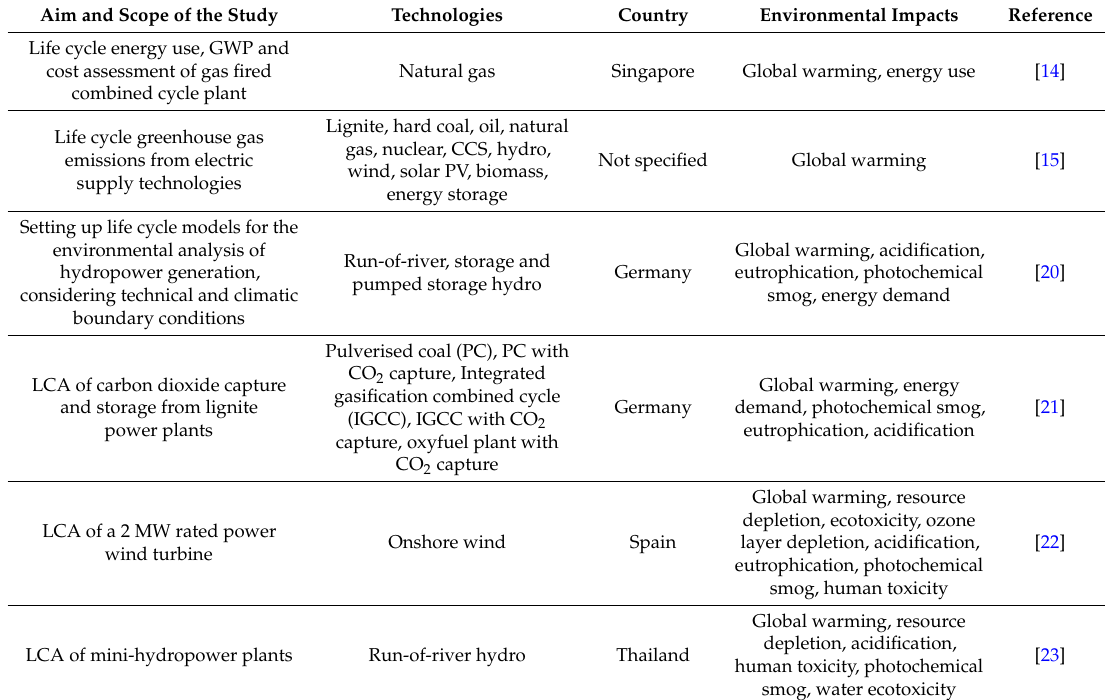
Table 1. Some life cycle assessment (LCA) studies of electricity